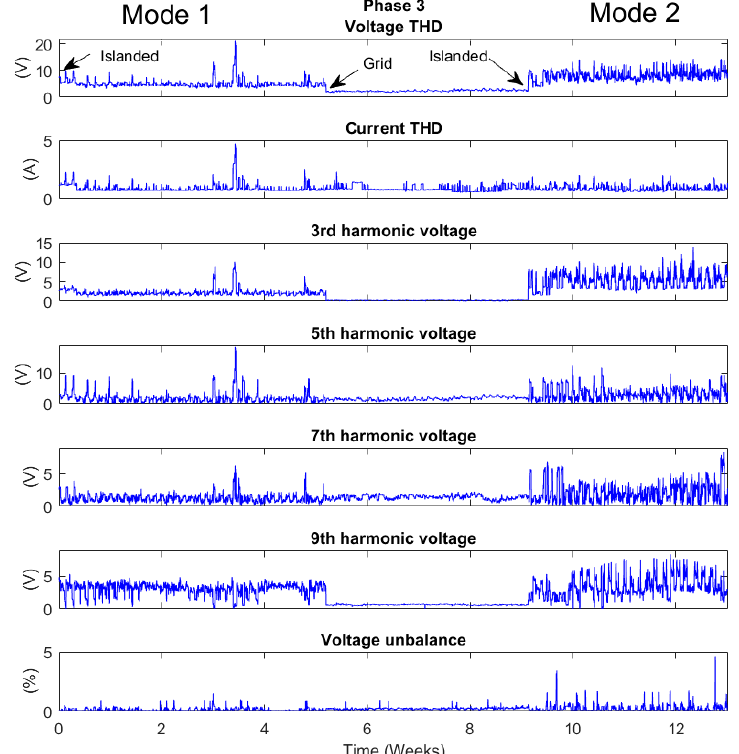
Figure 16. The voltage and current THD, 3rd, 5th, 7th, 9th harmonic voltage and voltage unbalance for phase 3 during a 13 week period in which the samples was extracted for a current rise larger than 4 A within 2 cycles.